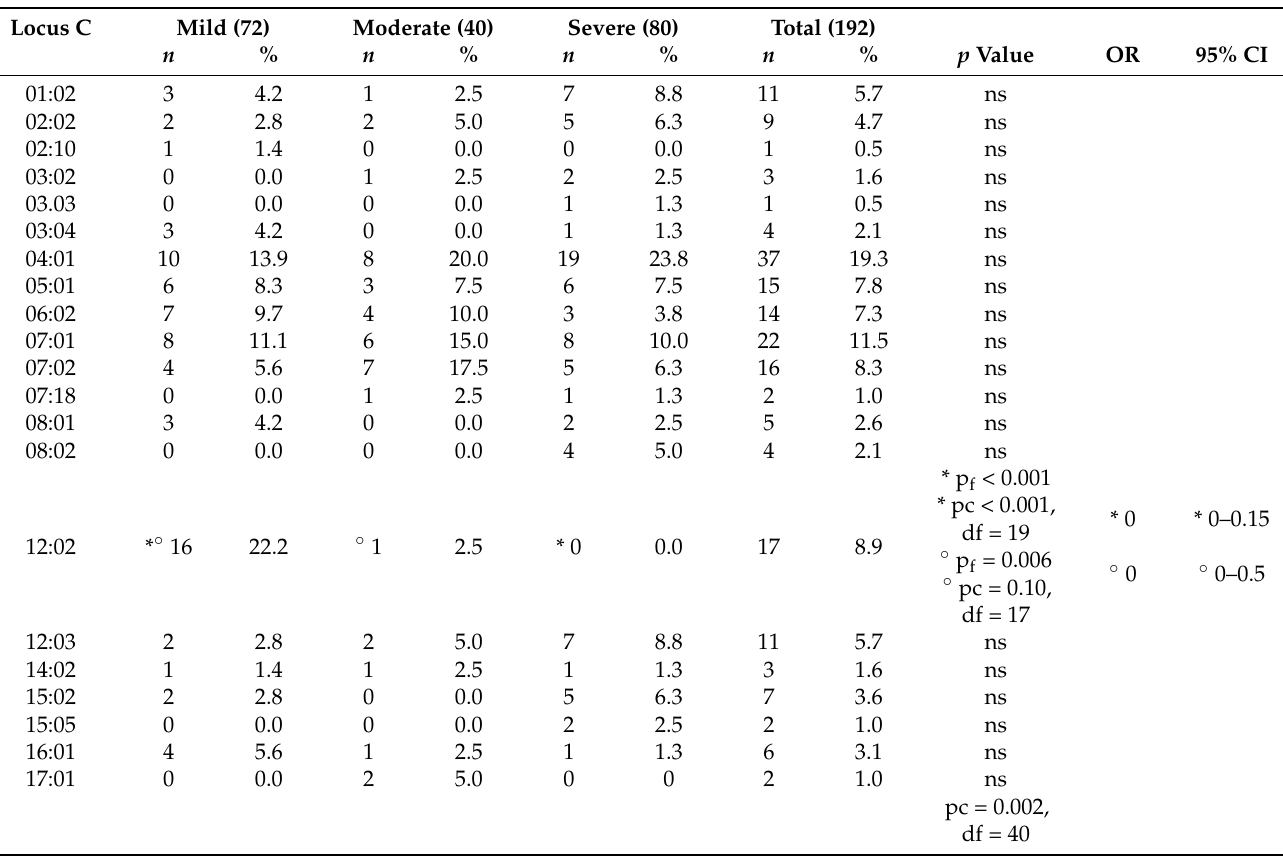
Table 4. Comparison of HLA-C frequencies of 96 Italian patients clustered on the basis of COVID-19 severity classification in line with Chen and colleagues